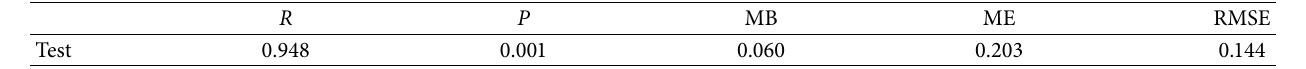
Figure 3: Comparison between Baiyangdian Wetland sample images and classification data of the model built based on GF-2 and Sentinel-2 data (a1 is region 1, a2 is the classification result of the model built based on GF-2 data in region 1, a3 is the classification result of the model built based on Sentinel-2 data in region 1, b1 is region 2, b2 is the classification result of the model built based on GF-2 data in region 2, and b3 is the classification result of the model built based on Sentinel-2 data in region Table 1: Accuracy test of the classification results of the model.